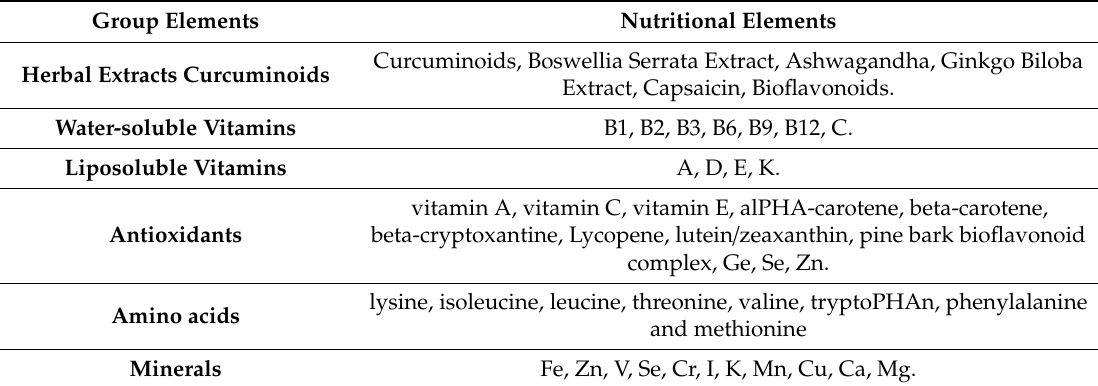
Table 2. Nutritional elements co-administrated with BioPerine ® that increase absorption.